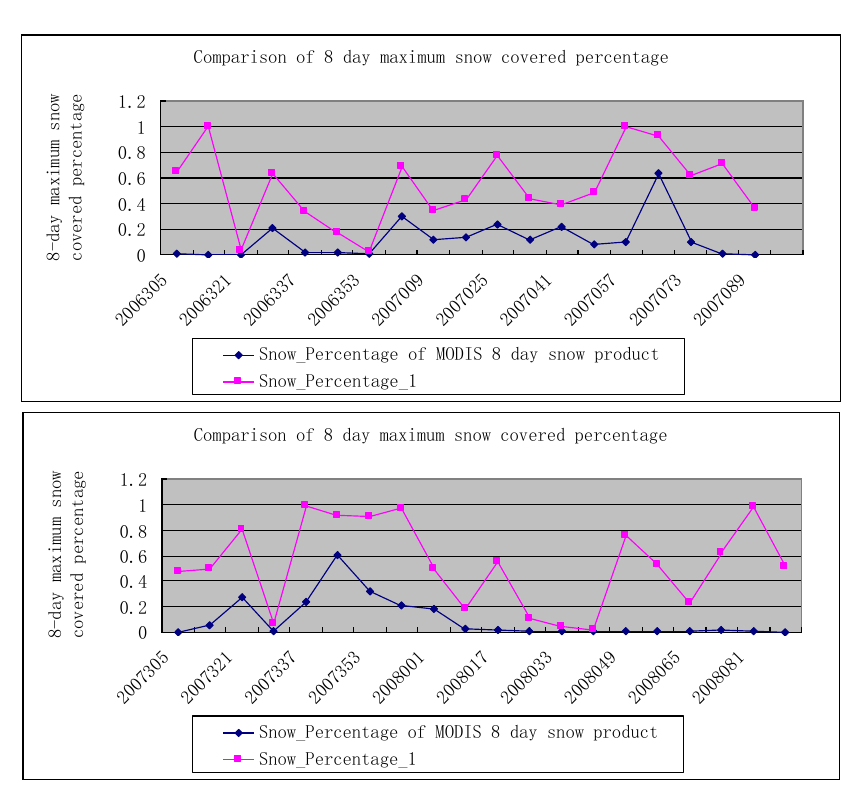
Figure 12. Comparison of the 8-day maximum snow covered percentage, for the